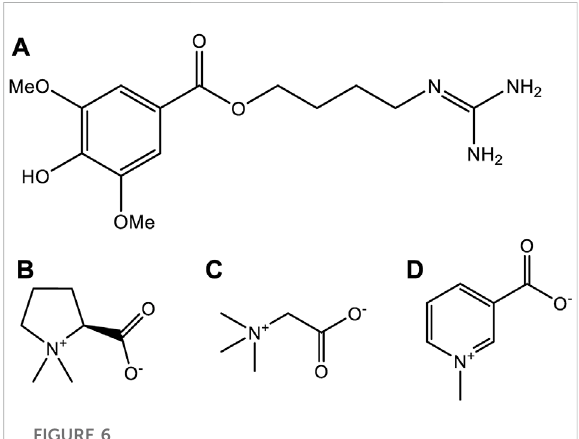
FIGURE 6 The chemical structures of four alkaloids from Herb Leonuri . (A) The chemical structures of leonurine. (B) The chemical structures of stachydrine. (C) The chemical structures of betaine. (D) The chemical structures of